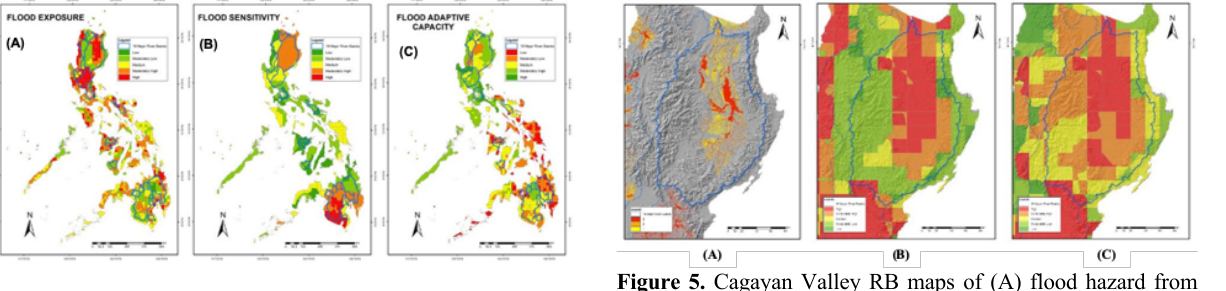
Figure 2. Nationwide maps of exposure, sensitivity and adaptive capacity with the locations of the 18 major river basins (RBs).